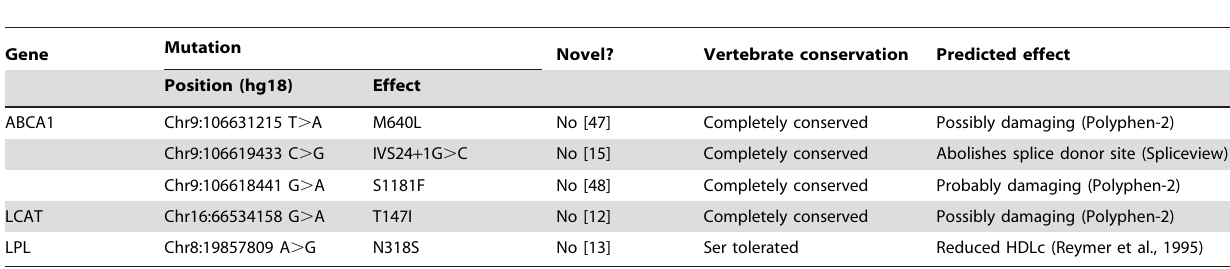
Table 5. Additional mutations in individuals with LIPG mutations and low HDLc.